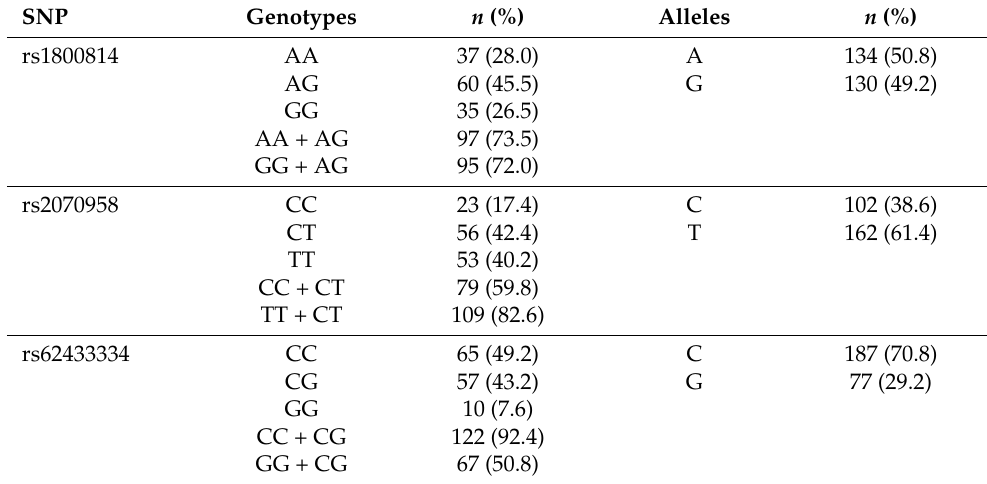
Table 3. Frequency of genotypes and alleles of analyzed SNPs of the PDGFA gene. SNP